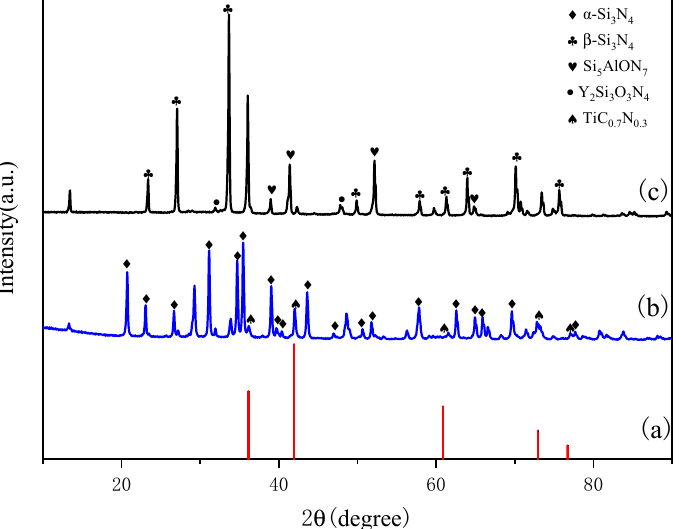
Figure 2. X-ray diffraction (XRD) patterns of SN2 samples before and after sintering at 1650 °C for 1 h: ( a ) Standard data for TiC 0.7 N 0.3 (PDF#42-1489); ( b ) Sample before sintering; ( c ) Sample after sintering.